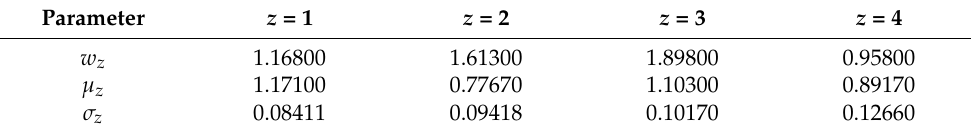
Table 2. Parameters of p trf ( x ) when the goal function is multi-Gaussian distribution. Parameter